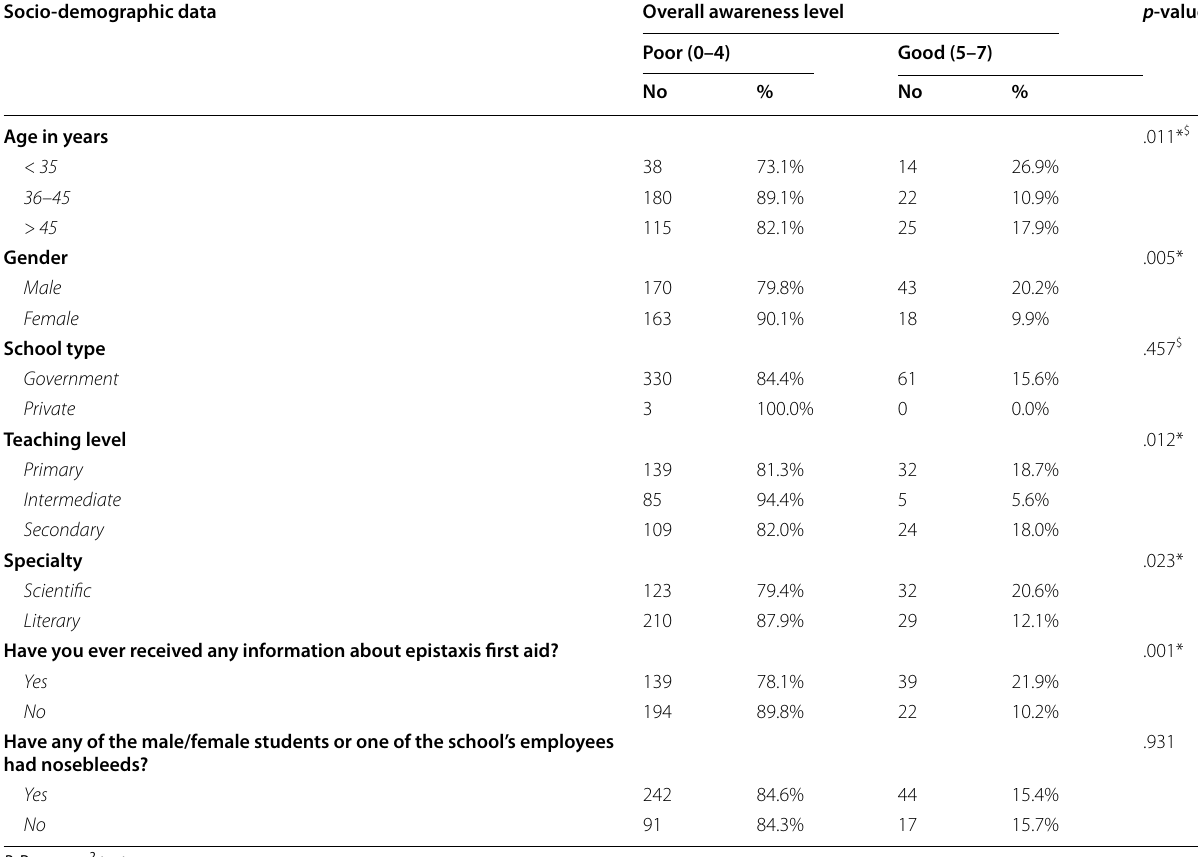
Table 3 Distribution of the teachers’ awareness level regarding the first aid of epistaxis according to their socio‑demographic